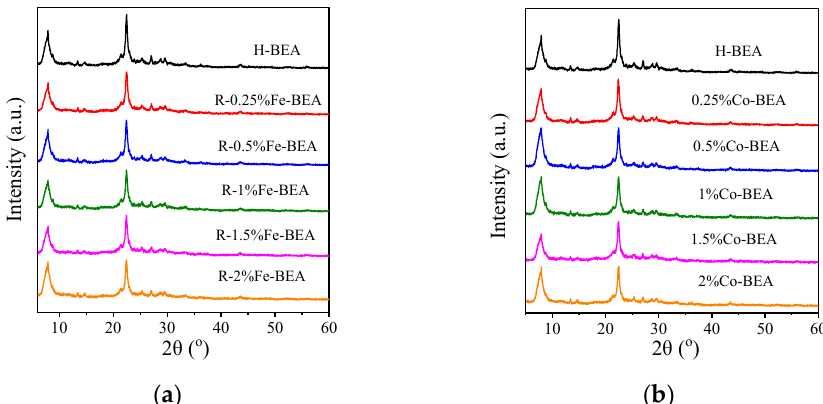
Figure 1. ( a ) XRD patterns of Fe-BEA with different concentrations; ( b ) XRD patterns of Co-BEA with different concentrations.